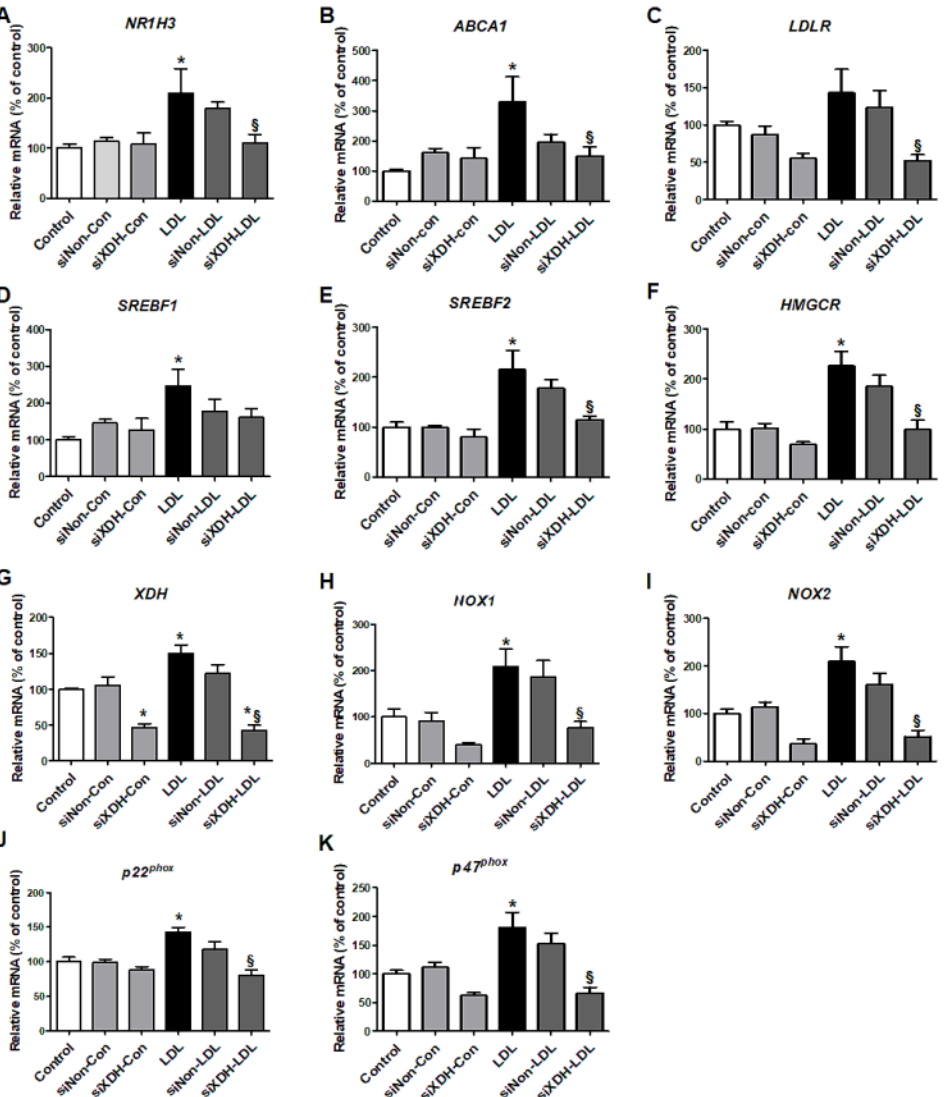
Figure 4. The effects of small interfering RNA against XDH (siXDH) on cholesterol metabolism and oxidative stress in LDL-stimulated HK-2 cells. After transfection with siXDH (20 µM) for 24 h, and stimulation with LDL (200 µg/mL) for 30 min, real-time RT-PCR was performed to determine